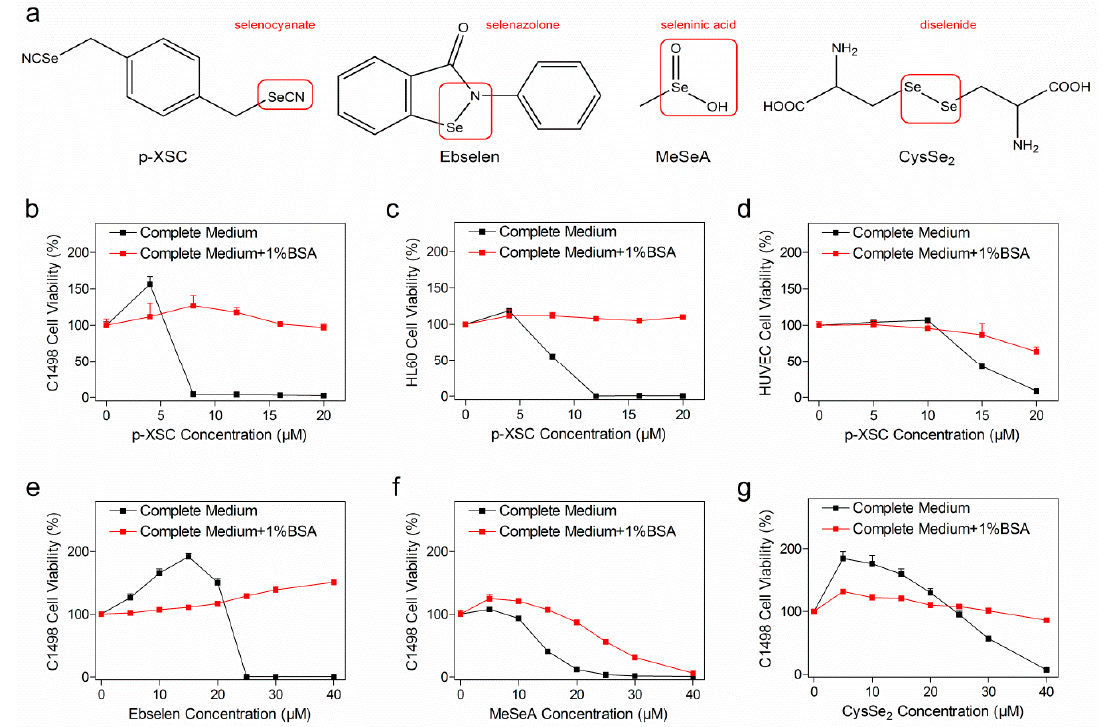
Figure 1. Cytotoxicity of selenocompounds (SeCs). ( a ) Chemical structures of SeCs with the functional groups marked in red. ( b – d ) C1498 (murine acute myeloid leukemia), HL60 (acute promyelocytic leukemia), and HUVEC (human umbilical vein endothelial cell) cell viability after p-xyleneselenocyanate (p-XSC) treatment. ( e – g ) C1498 cell viability after treatment with ebselen, methylseleninic acid (MeSeA), or selenocystine (CysSe 2 ). In all experiments, the exposure time was 24 h and cell viability was assayed by WST-1 kit. The treatment was performed in appropriate complete medium for each cell line without (black line and dot) or with (red line and dot) 1% extra BSA. Results are shown as the mean ± standard deviation of six biological replicates.